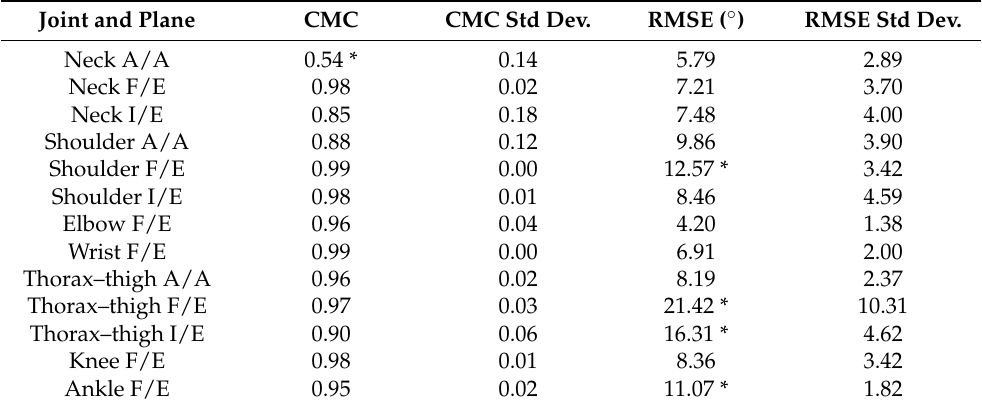
Table 1. Coefficient of multiple correlation, root mean square error and standard deviation values between Xsens MVN and Qualisys. Joint and Plane CMC CMC Std Dev.